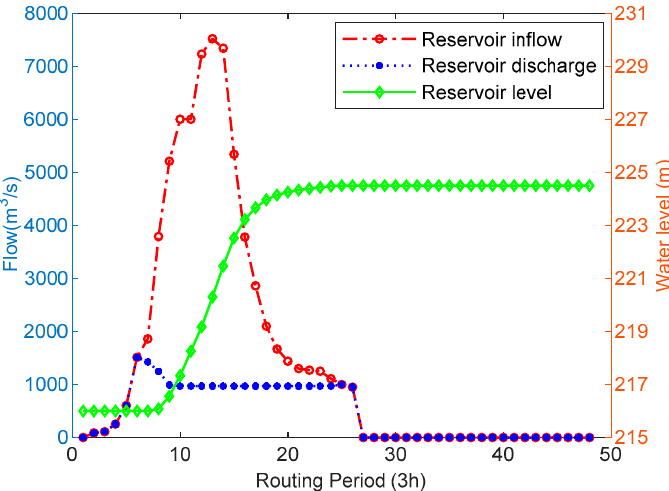
Figure 6. Operation process using CF-CABES for reservoirs in Luanhe River Basin.